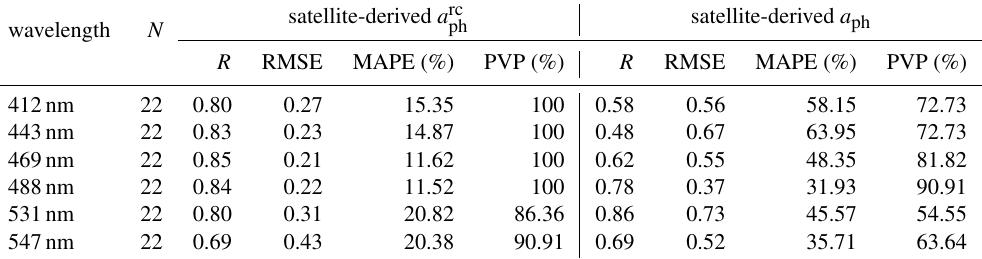
Table 5. Results of the matchup comparison for Fig. 6.